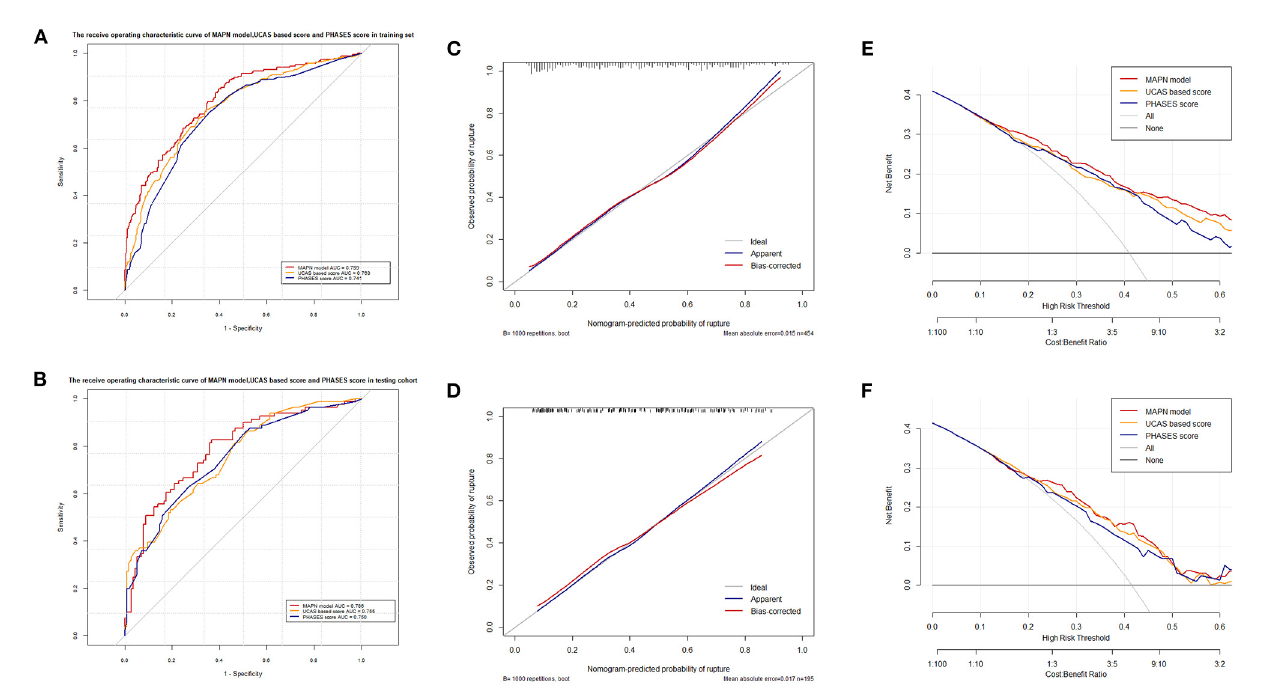
FIGURE5 (A, B) shows the different AUC values of the three prediction models in the training and validation sets, respectively. (C, D) shows the different calibration curves of the three prediction models in the training and validation sets, respectively. (E, F) shows the different decision curve analyses of the three prediction models in the training and validation sets, respectively.